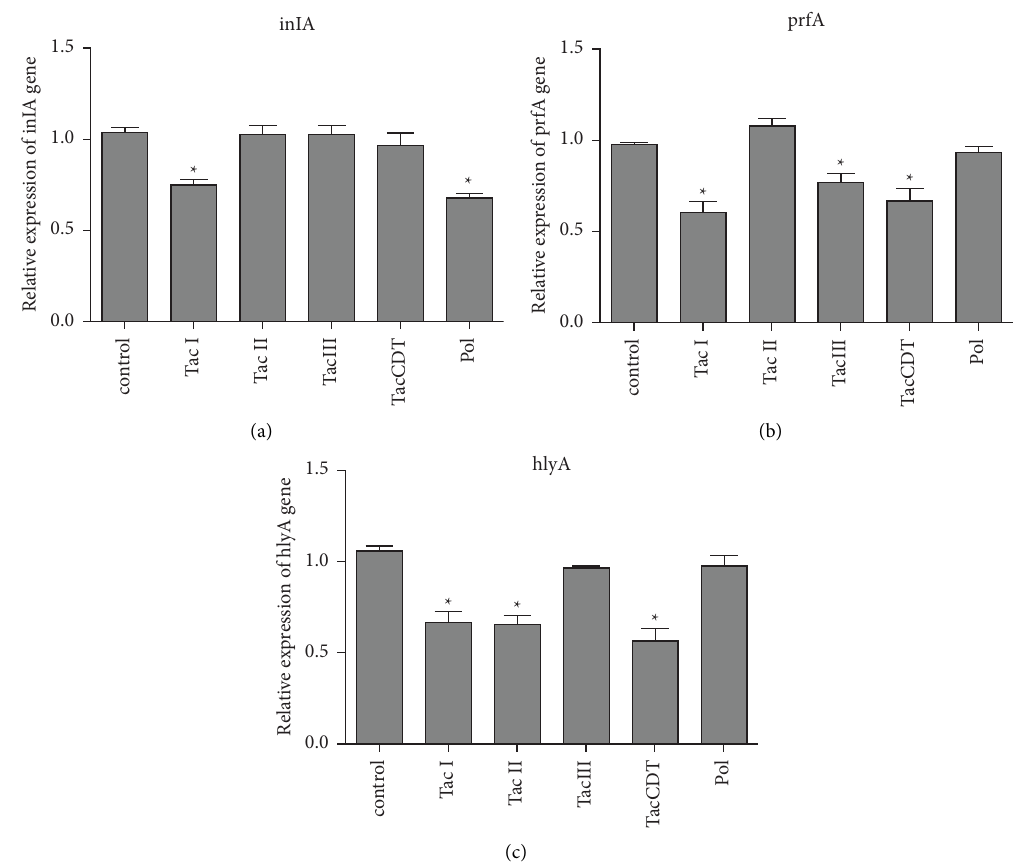
Figure 4: Te efects of the fve sLAMPs on (a) the relative expression of the inlA gene, (b) relative expression of the prfA gene, and (c) relative expression of the hly gene. Te genes are virulence genes in LM. ∗ p < 0 . 05, ∗∗ p < 0 .